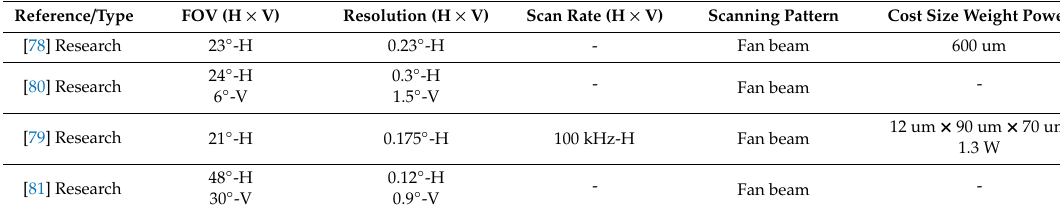
Table 5. Comparison of performance and SWaP specifications for selected PCW